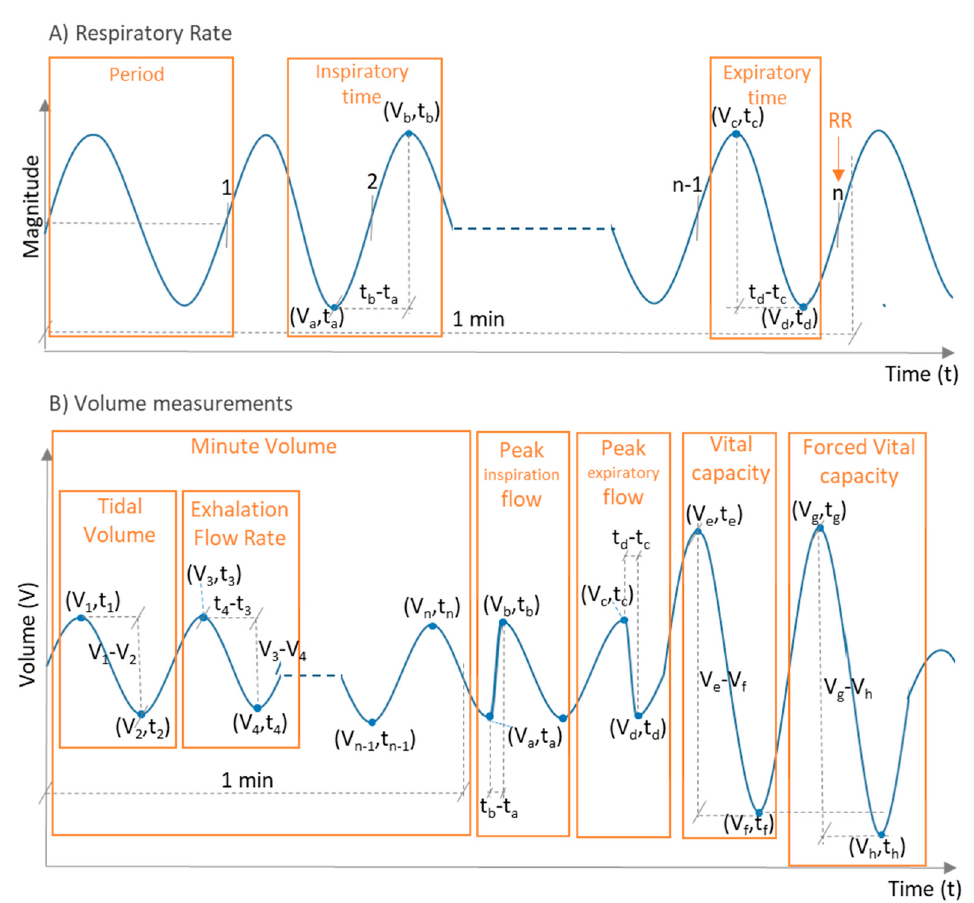
Figure 4. Graphical explanation of the different breathing parameters. Signal ( A ) could come directly from the ADC (analog-to-digital converter) of the sensing system, although it is also possible that it represents physical respiration magnitudes. This figure shows a general representation that is not contextualized to a specific sensing system. The same goes for signal ( B ).